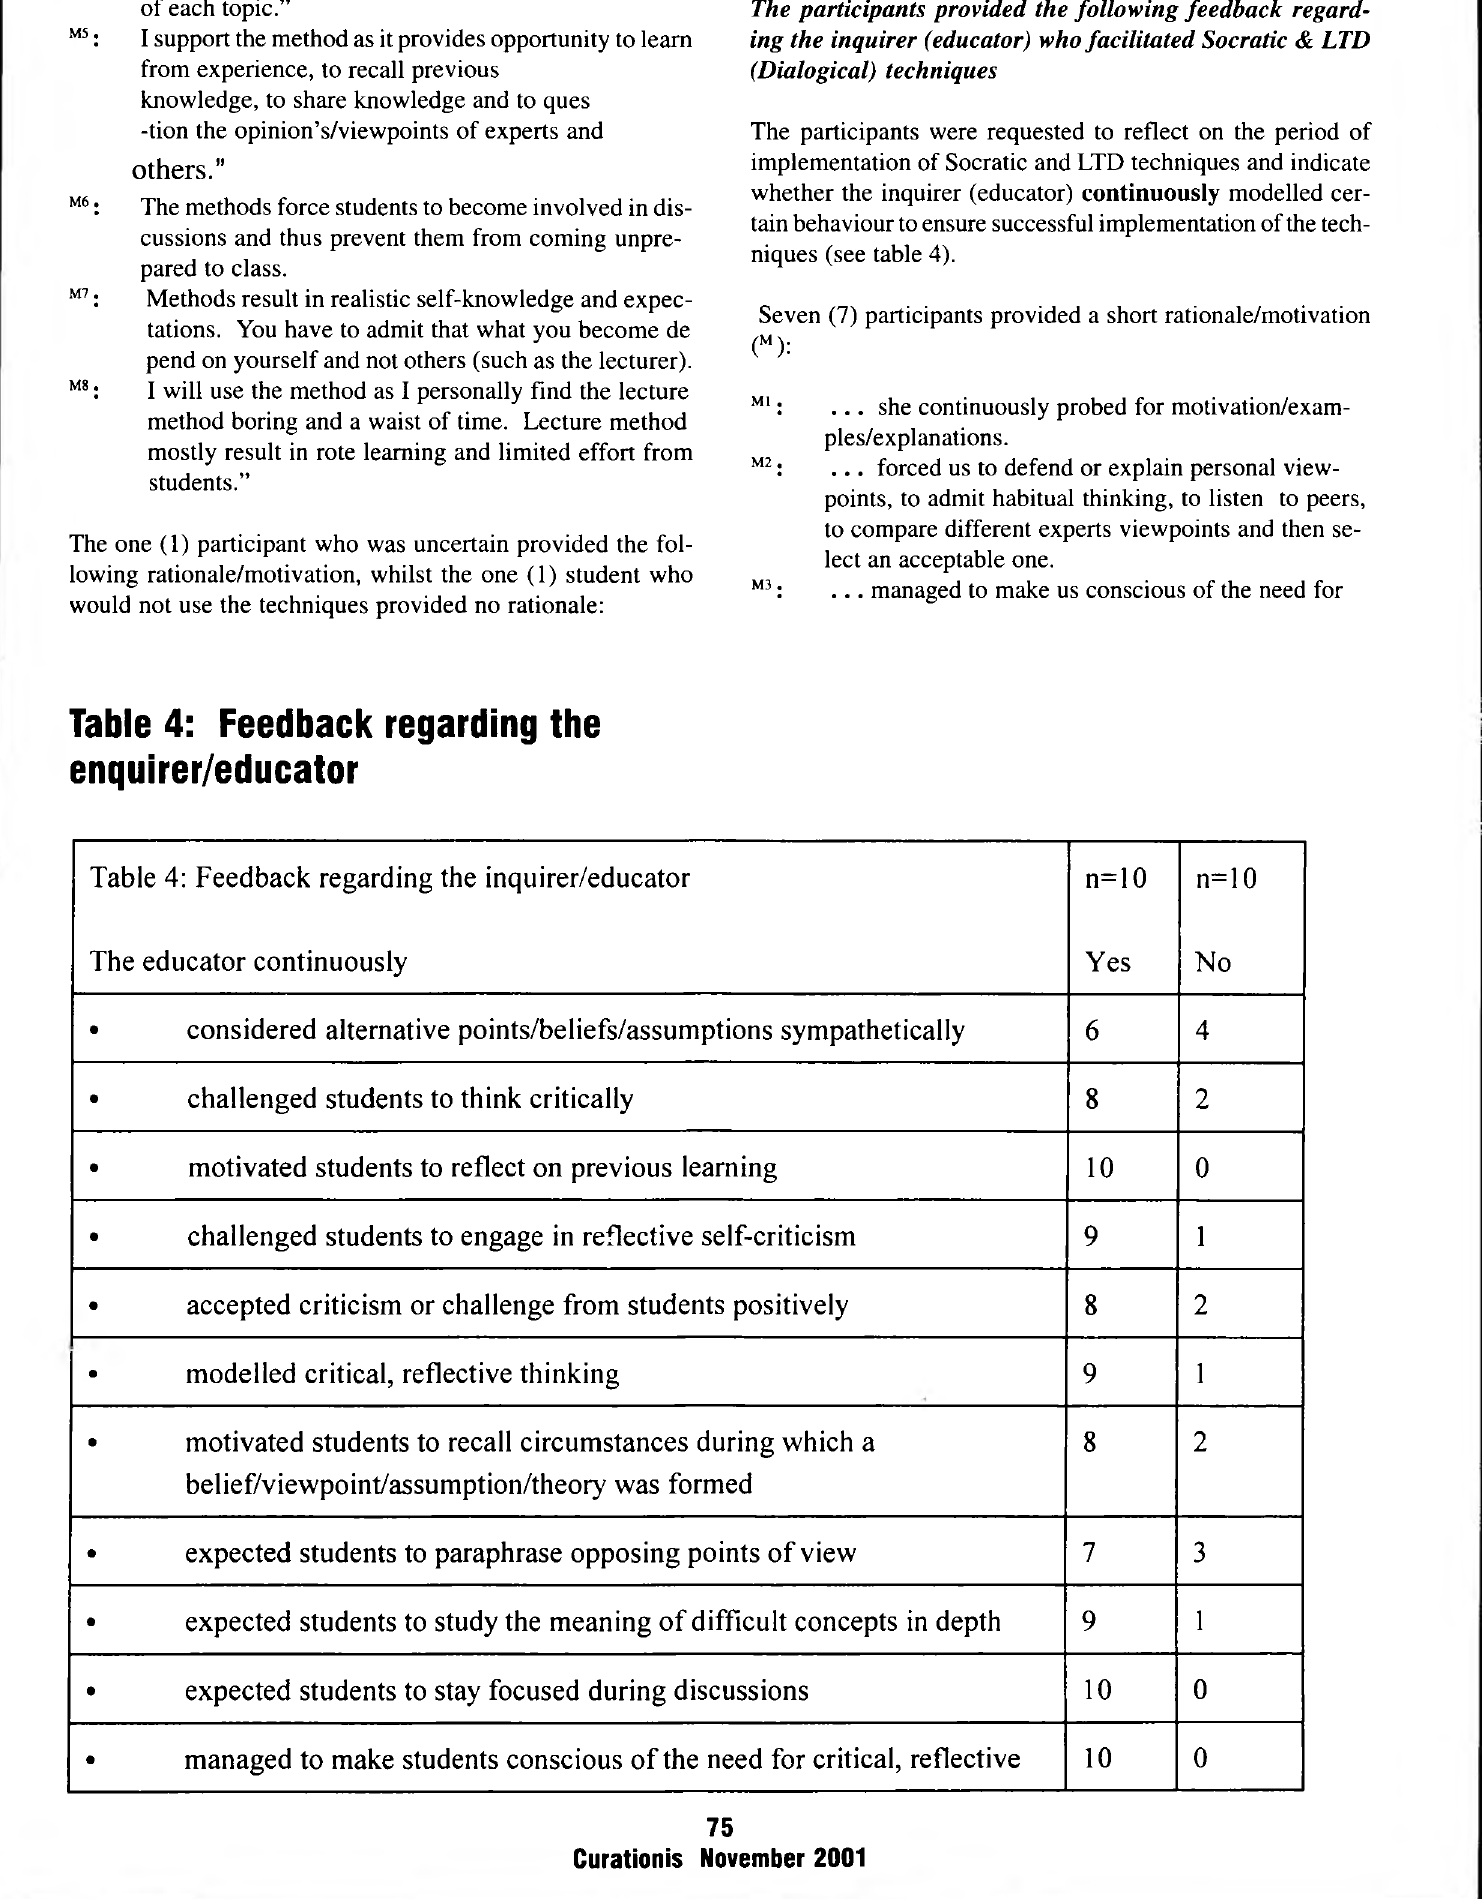
Table 4: Feedback regarding the inquirer/educator The educator